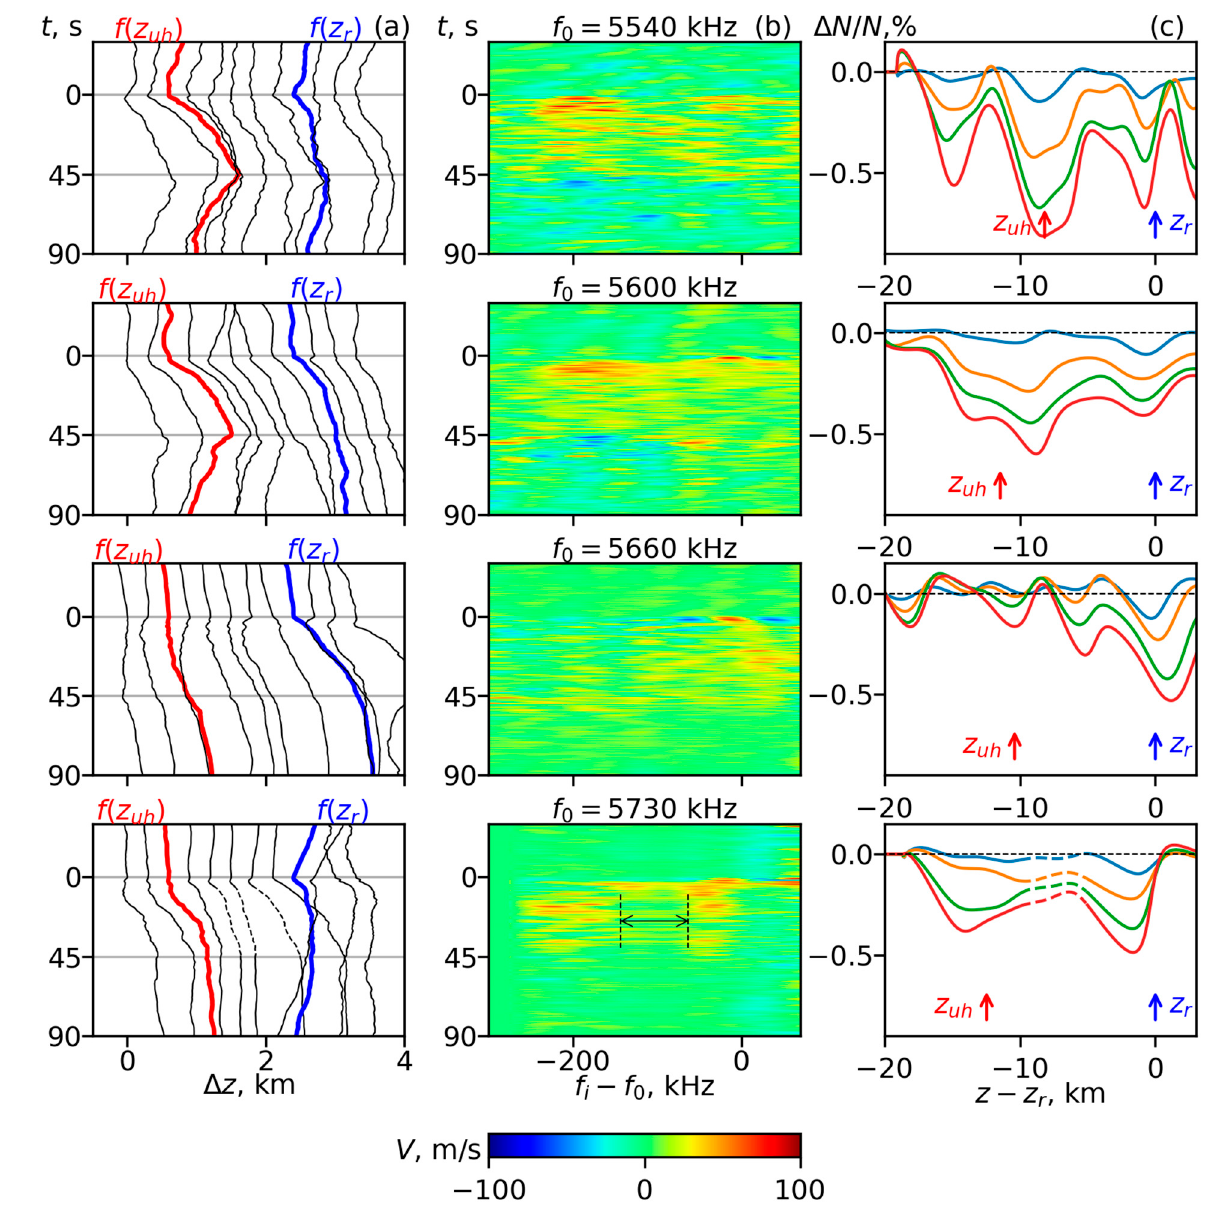
Figure 2. Results of the phase data processing for the PW reflection heights z r0 ≳ 230 km. The PW frequencies f 0 are shown above the ( b ) panels. Column ( a ): Temporal variations of the reflection height shifts of different spectral components of the sounding pulses ∆ z ( f i , t ) for different cycles. The frequency step between shown spectral components ∆ f i = 60 kHz, starting from f 0 . An additional height shift of 300 m between the reflection heights of the successive shown frequencies f i at t = 0 was added for clarity. Red and blue lines correspond to the spectral components that were reflected from z UH and z r . Column ( b ): Velocity of the sounding waves reflection height displacement V v = ∂ ∆ z r ( f i , t)/ ∂ t vs. time and frequency. Column ( c ): Relative variations of the electron density [ N ( t ) − N (0)]/ N (0) vs. height at t = 5 s (blue), 15 s (orange), 30 s (green) and 45 s (red) in the same cycles. Double arrows show the contaminated frequency range for the data